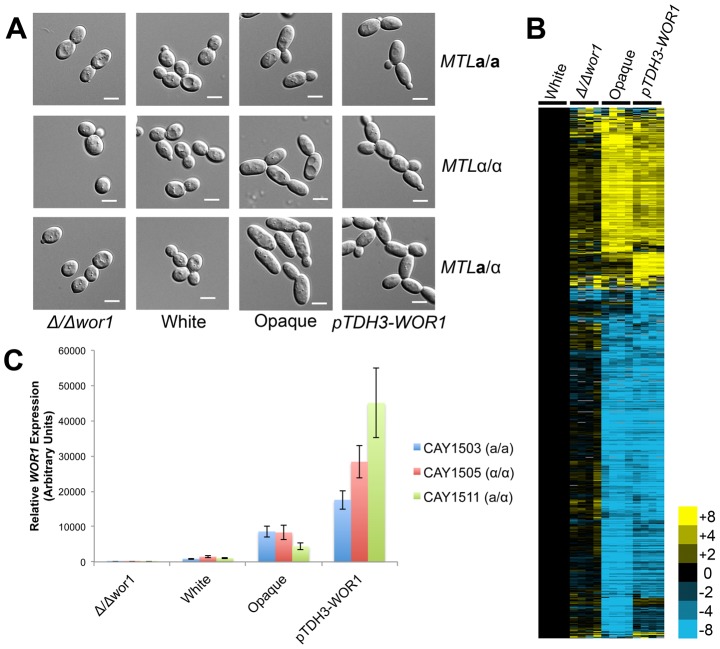

WOR1 is the master regulator of the white-opaque switch in C. tropicalis.(A) Cell morphologies of Δwor1, white, opaque, and pTDH3-WOR1 (WOR1-overexpressing) strains. Cells were grown in Spider medium at room temperature to 0.8–1.0 OD600. Scale bars = 5 µm. (B) Gene expression in a/α white cells (CAY1511), Δwor1 cells (CAY4043), opaque cells (CAY4048), and pTDH3-WOR1 cells (CAY4045), relative to white cells (CAY1511). Expression profiles for each state were divided by white expression values and filtered for those genes with an expression change greater than 4-fold in 4 or more experiments. (C) WOR1 expression in Δwor1, white, opaque, and pTDH3-WOR1 strains derived from a, α, and a/α cells. Expression levels measured by qRT-PCR. Error bars indicate SEM for replicate experiments from 3 different biological replicates.